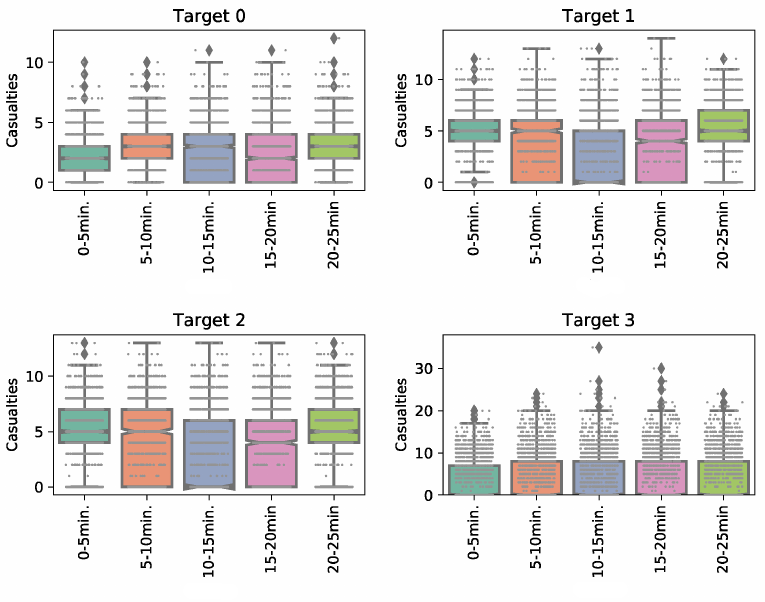
Figure 10. Number of casualties per target per time in each simulation run. Please note that the axis scales are different among targets. Two outliers (40 and 56 casualties), at T 3 between 20 and 25 min, were omitted from the figure to enhance readability. Table 5. Empirical results for the optimal patrolling strategy in the verification step. All other movement probabilities are zero. Start Node End Node